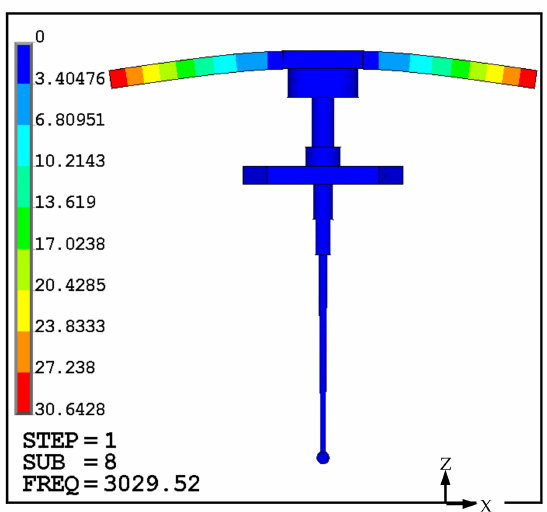
Figure 5. The eighth mode shape of the Type B flapper-armature